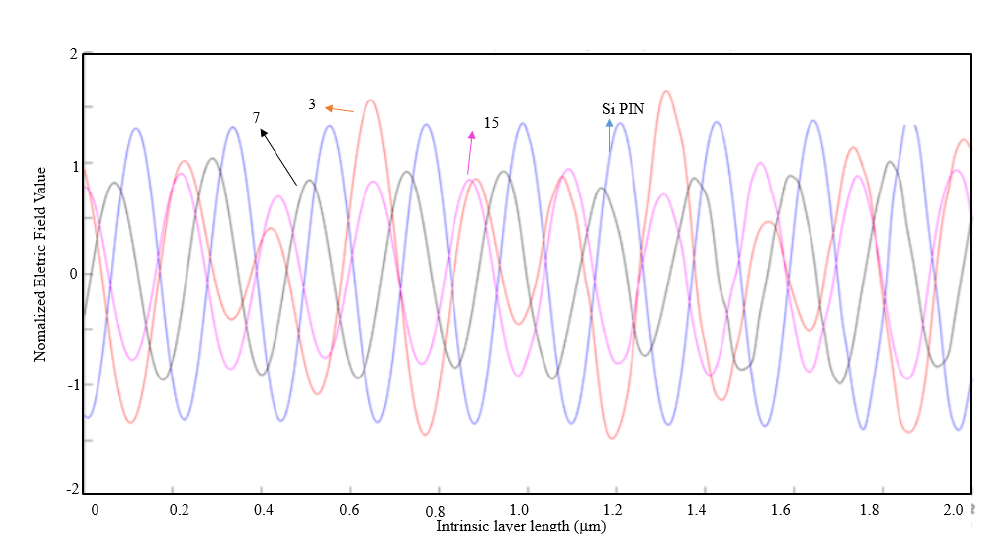
Figure 18. 1D Plot of the normalized electric field, z-component, along the intrinsic zone for a light wavelength of 800 nm (metal thickness: λ /100; air slit width: λ /10).